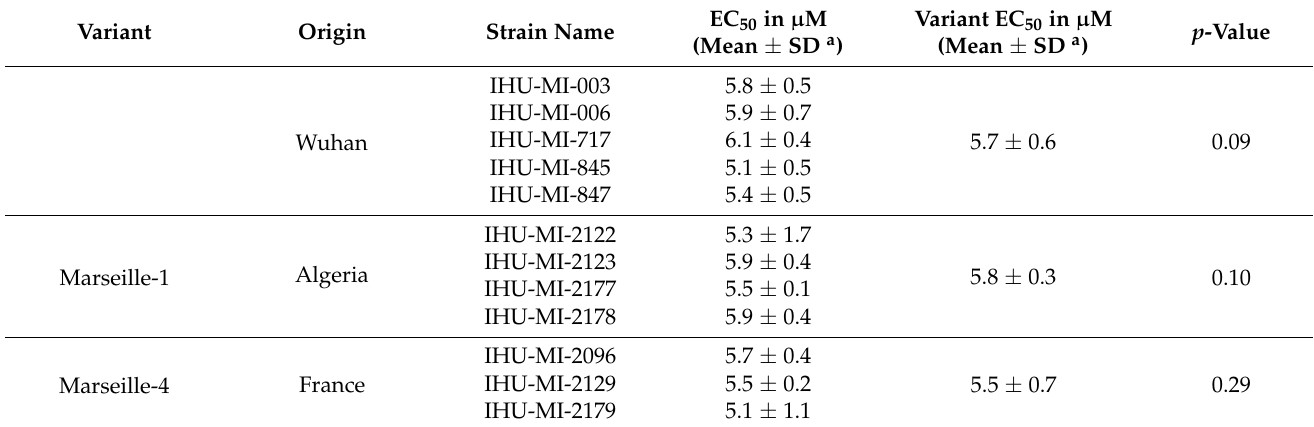
Table 1. In vitro susceptibility of different clinically isolated SARS-CoV-2 variants of concern or interest to